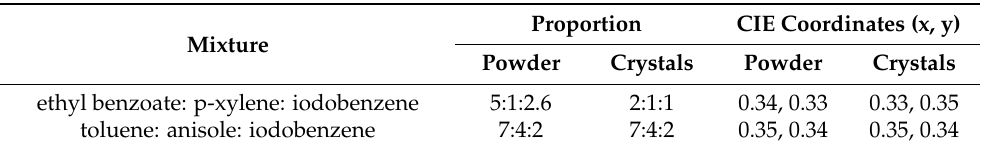
Table 1. VOC proportions for the achievement of the white light with the different mixtures and their corresponding CIE coordinates, both in powder sample and single crystals. Mixture Proportion CIE Coordinates (x, y) Powder Crystals Powder Crystals ethyl benzoate: p-xylene: iodobenzene 5:1:2.6 2:1:1 0.34, 0.33 0.33, 0.35 toluene: anisole: iodobenzene 7:4:2 7:4:2 0.35, 0.34 0.35, 0.34